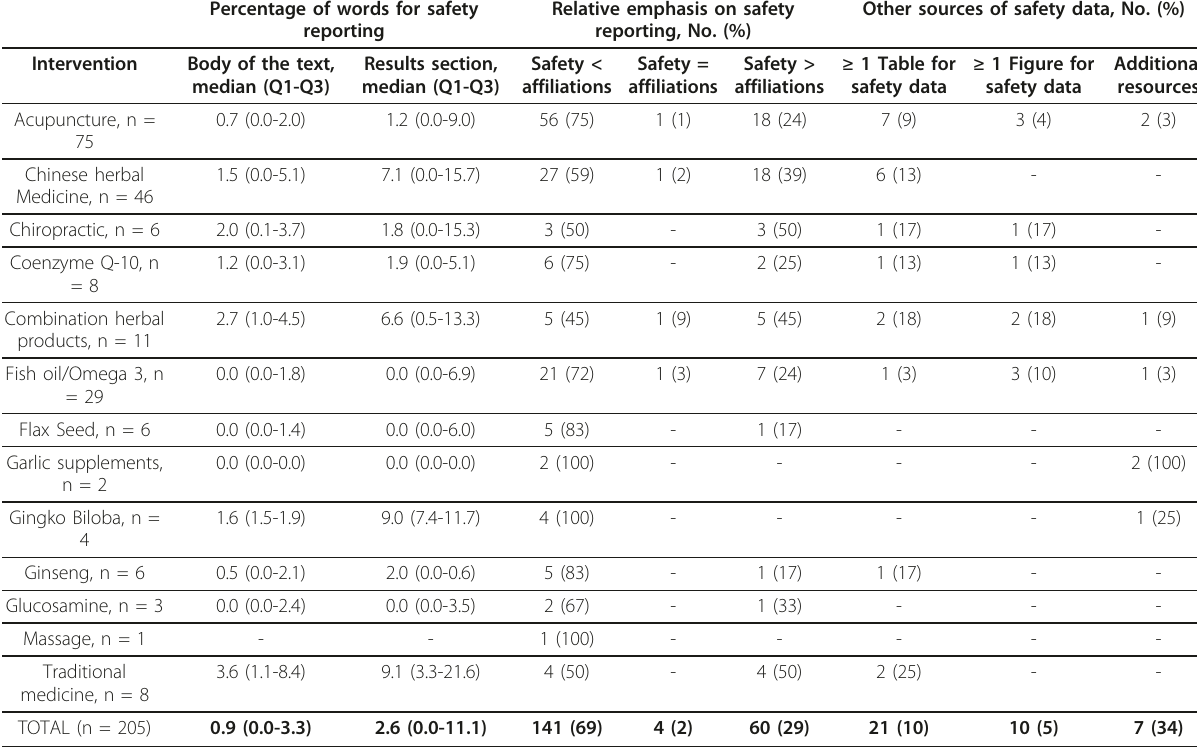
Table 3 Safety of Reporting: Quantitative measures